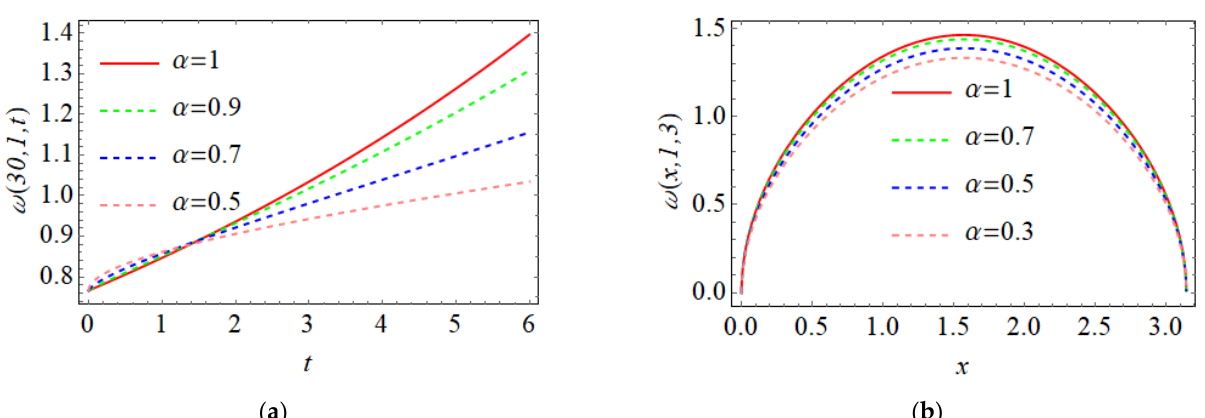
. . . (cid:2870) (cid:2870) 2